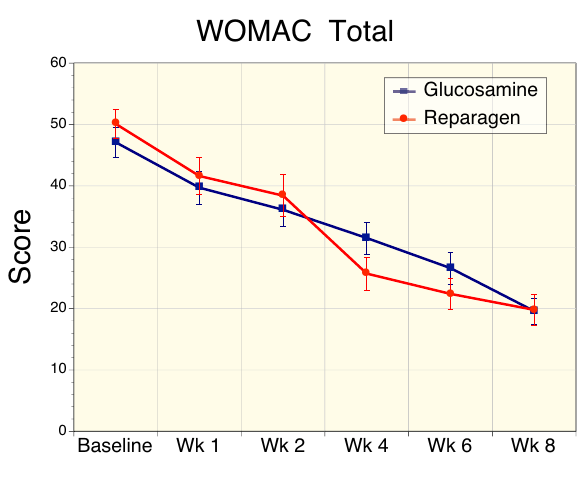
Figure 4 Sequential changes in WOMAC stiffness scores for repara- gen (red, n = 48) and glucosamine sulfate (blue, n = 47). Both treatments resulted in a significant reduction in baseline stiff- ness scores from week 2 onwards (p < 0.001), but only the reparagen treated group was significant at week 1 (p < 0.01). Sustained administration resulted in a time-dependent decrease in stiffness scores (p < 0.001)